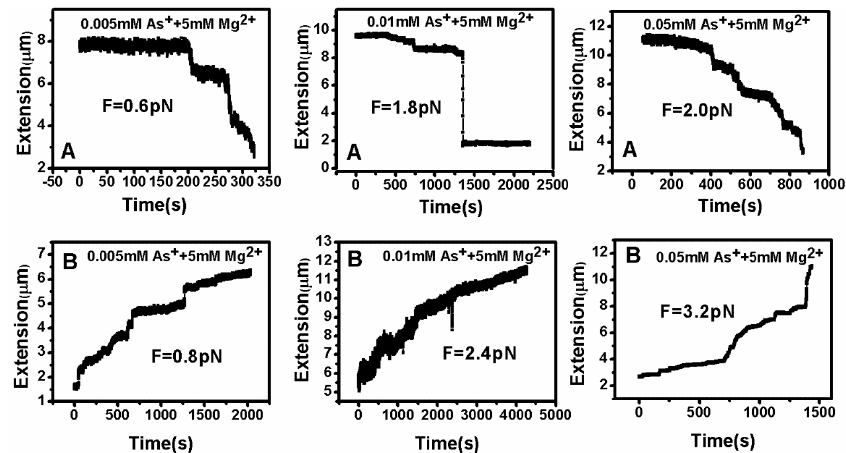
Figure 5. DNA extension–time curves under the influence of Ph 4 As + . ( A ) The shrinking of DNA at pulling force 0.5 pN; ( B ) unraveling of DNA condensed structures. Polymers 2017 , 9 , 128